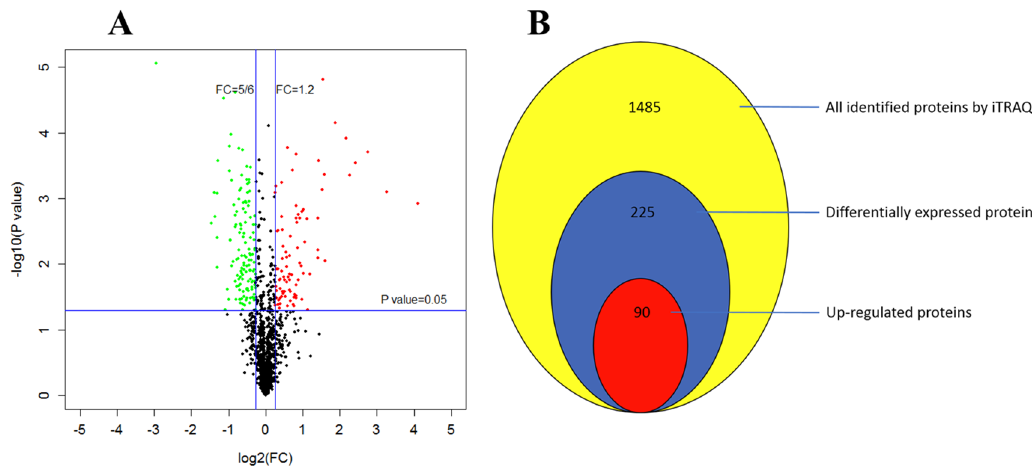
Figure 7. Cuminal exposure regulated gene expression of T. roseum at protein level. ( A ) The volcano plot of detected proteins indicating significantly up (red) and down (green) regulated proteins. ( B ) Comparison of the numbers of all identified proteins and di ff erentially expressed proteins (up vs. down